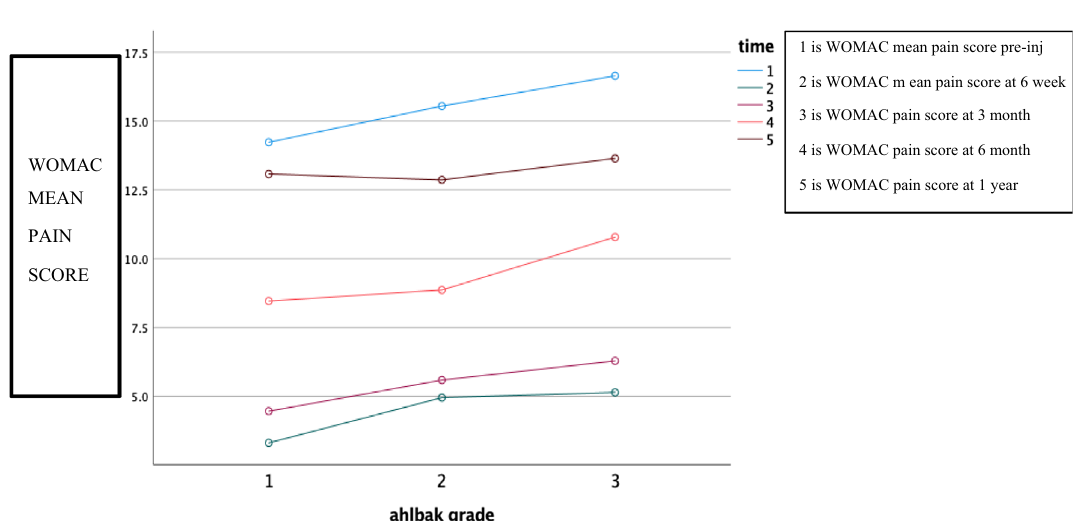
Figure 1. In fl uence of knee degeneration on WOMAC scores. The overall best improvement after six months and 1 year was observed in Ahlbäck I sub-group and the overall least improvement in Ahlbäck III sub-group. This shows a statistically signi fi cant improvement ( p < 0.05) in all sub-groups after PRP